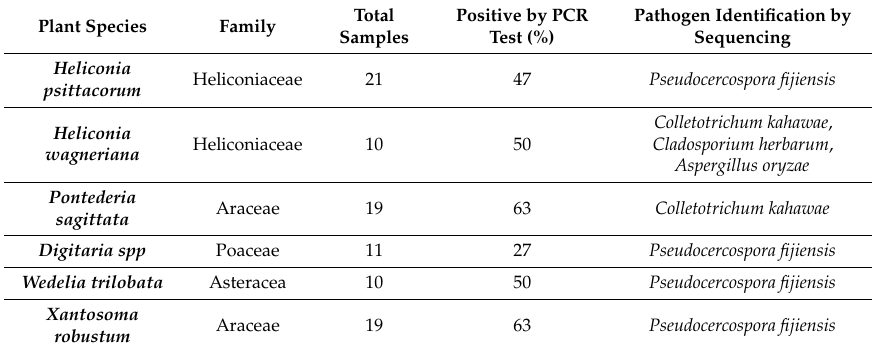
Table 1. Identification of fungi in plant species with leaf spots similar to black Sigatoka symptoms. Plants were collected inside and around banana crops in Tabasco and Chiapas, M é